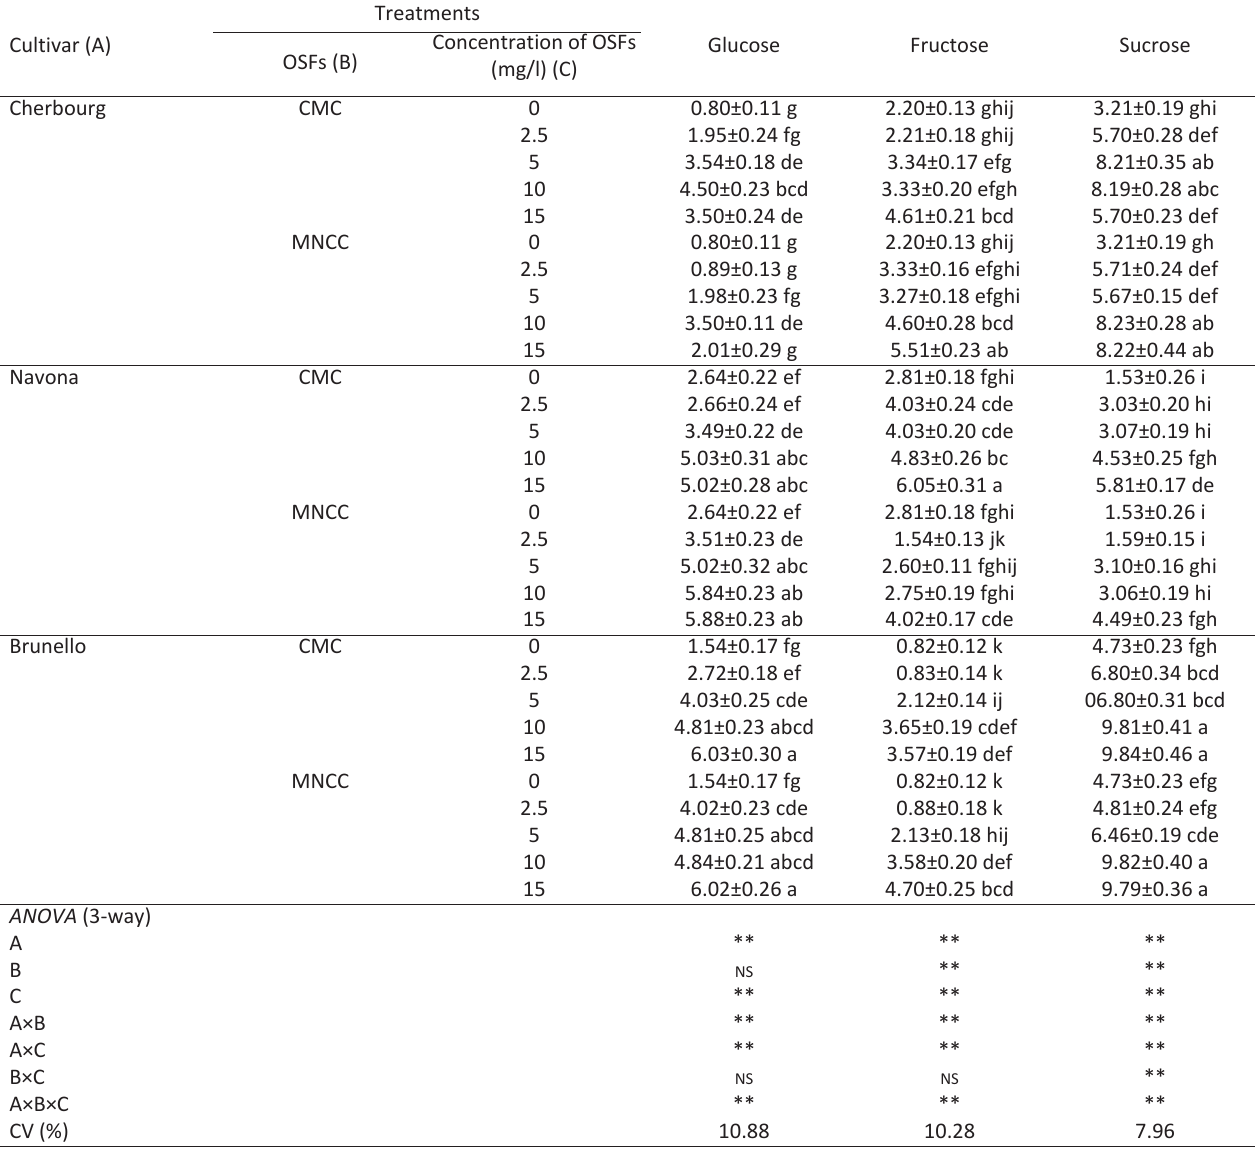
Table 3 - Effects of OSFs on soluble carbohydrates into the terminal bud tissue of inflorescence in three lily